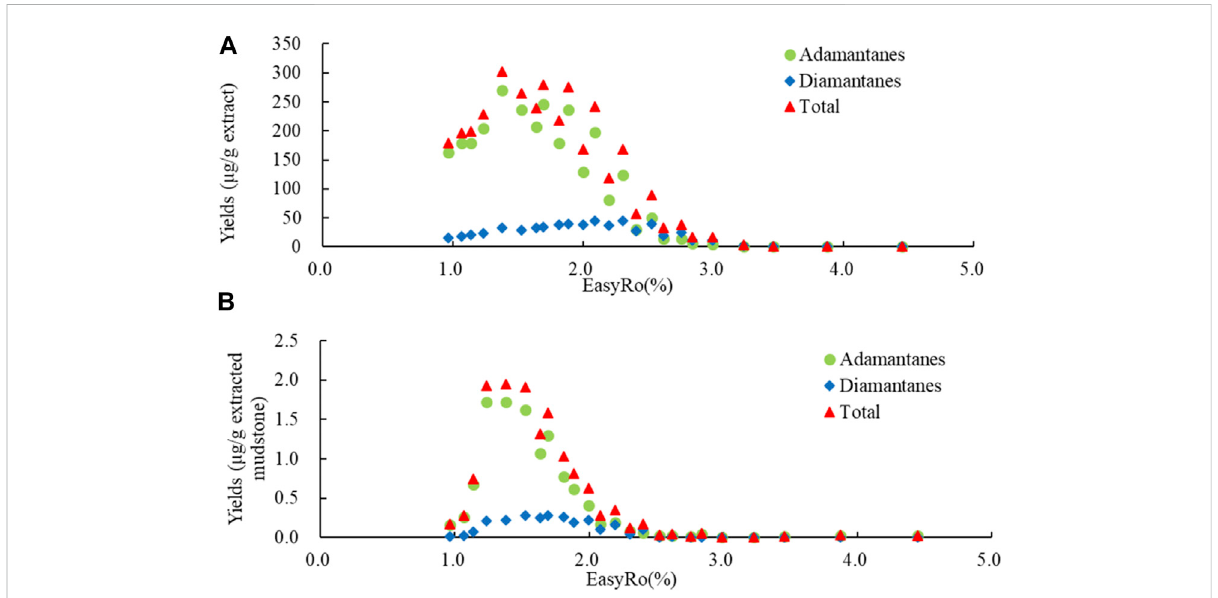
Variation in the diamondoid yields ( μ g/g) with EasyRo (%) during (A) extracts and (B) extracted mudstones pyrolysis. Total represents all adamantanes and diamantanes in Table